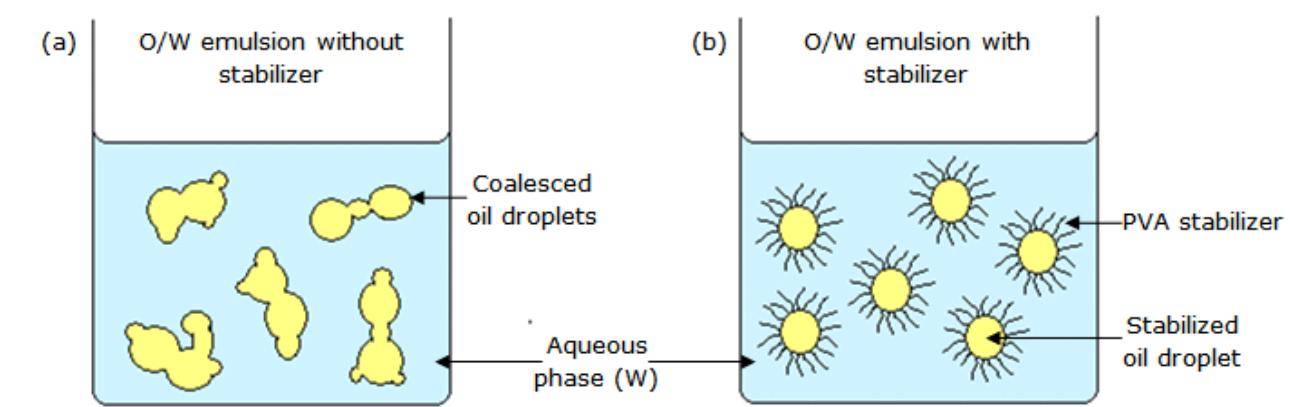
Figure 5. Schematic diagram of an O/W emulsion: ( a ) without; and ( b ) with a stabilizer.